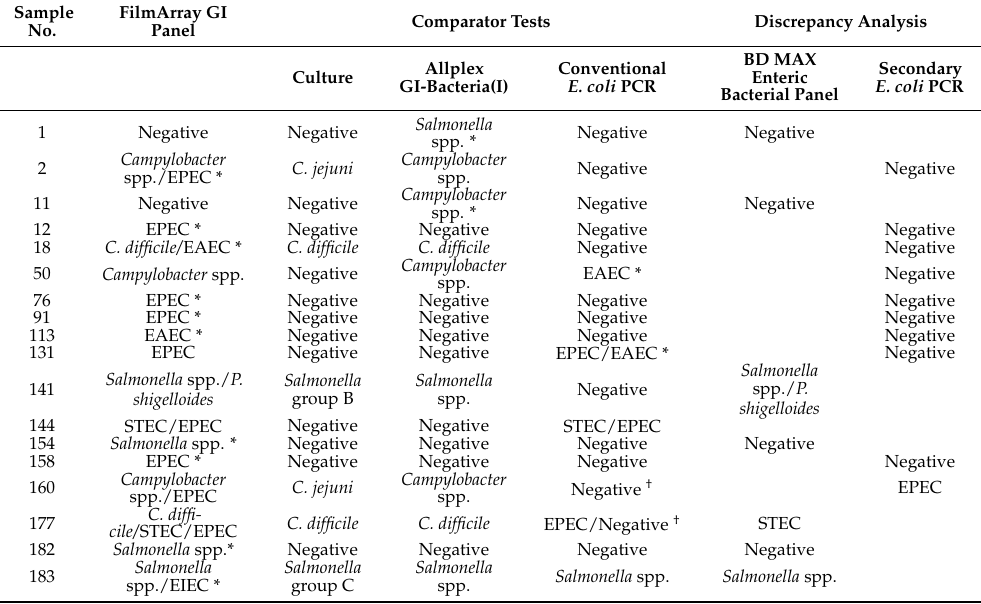
Table 4. Discrepancy analysis of bacteria detected via the FilmArray GI Panel and comparator tests. Sample FilmArray GI No. Panel Comparator Tests Discrepancy Analysis Culture Allplex GI-Bacteria(I) Conventional E. coli PCR